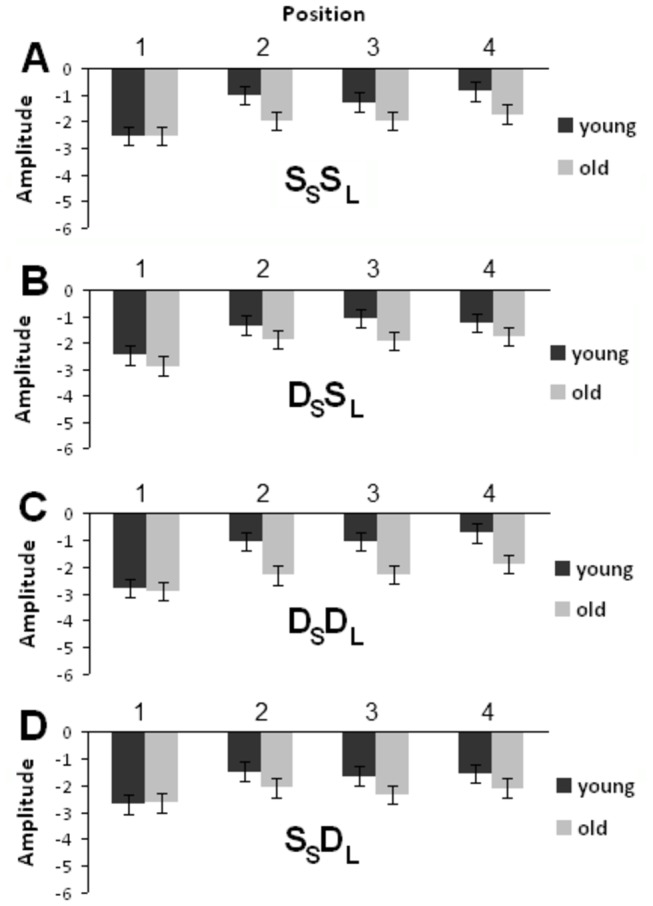
Plot of N1 peak amplitudes across the four positions regardless of noise.(A) SSSL trials. (B) DSSL trials. (C) DSDL trials. (D) SSDL trials. Error bars indicate standard error of the mean.